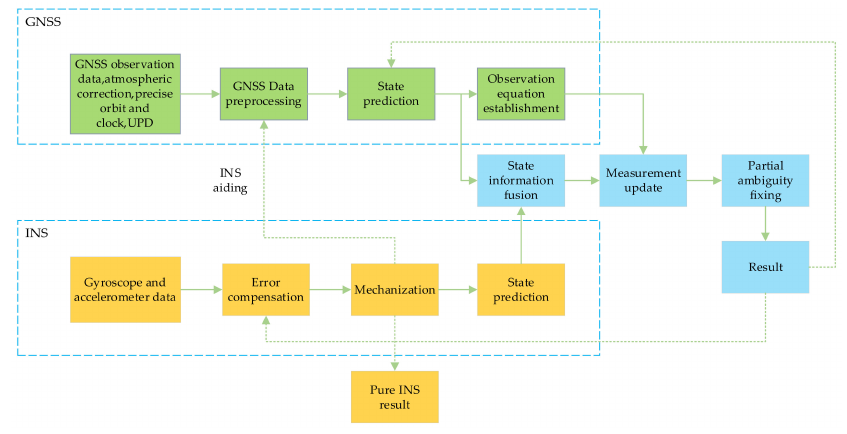
Figure 1. Flow chart of PPP-RTK/INS tight integration.